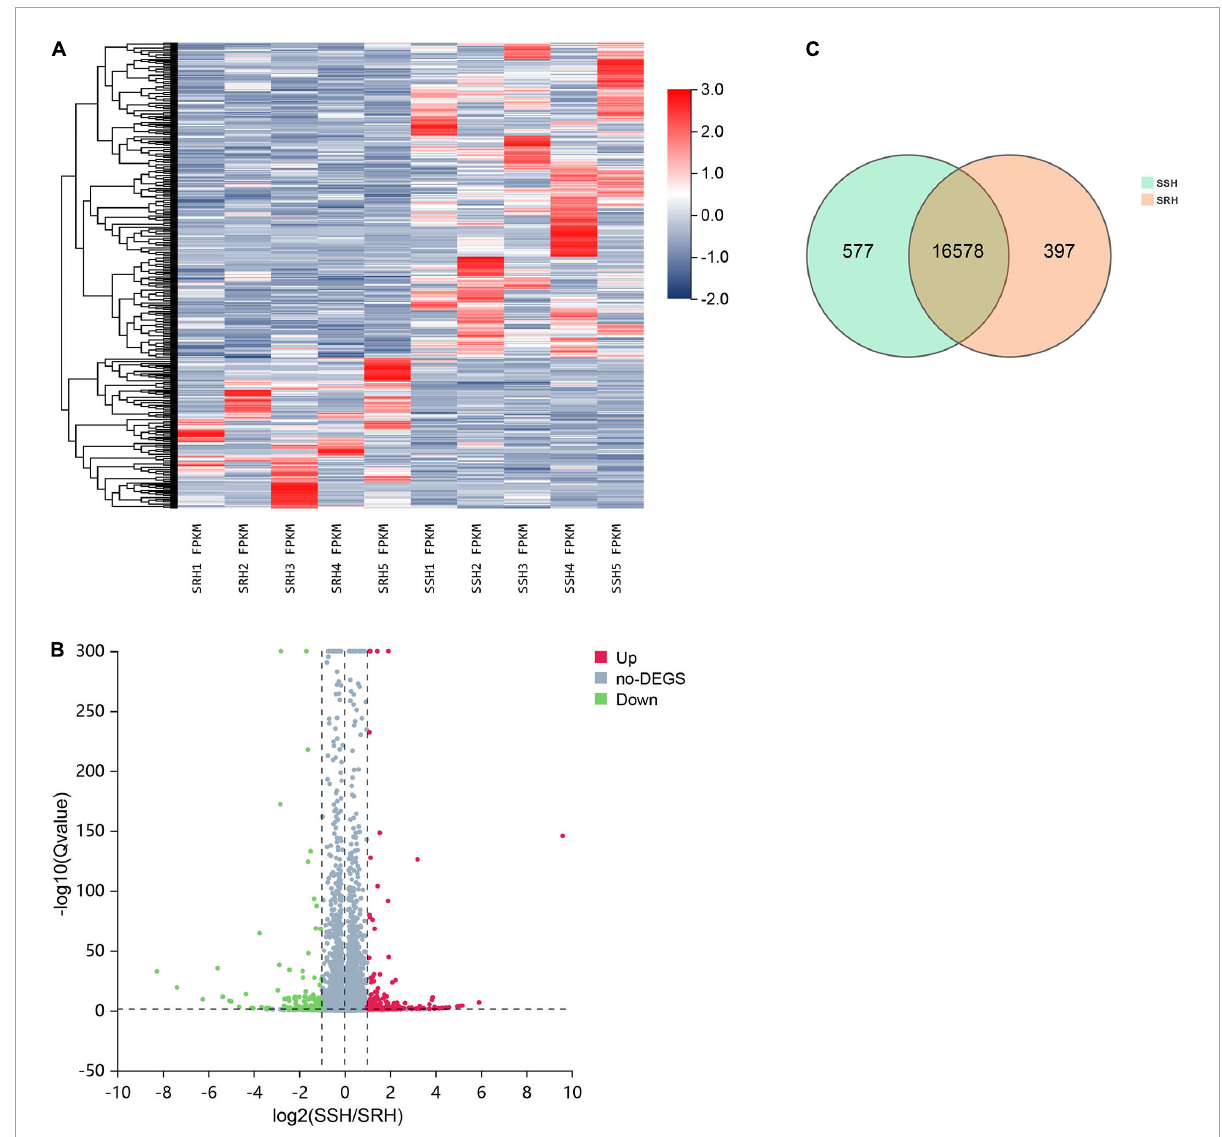
FIGURE1 The discrepancy between salt-sensitive hypertension (SSH) and salt-resistant hypertension (SRH) in terms of gene expression profile. (A) Hierarchical cluster analysis of genes identified in SSH and SRH. (B) Distribution of the genes expressed in the two groups, red dots and green dots indicates genes significantly up-regulated or down-regulated in the SSH and SRH. (C) Number of Gene expressed in the two groups.